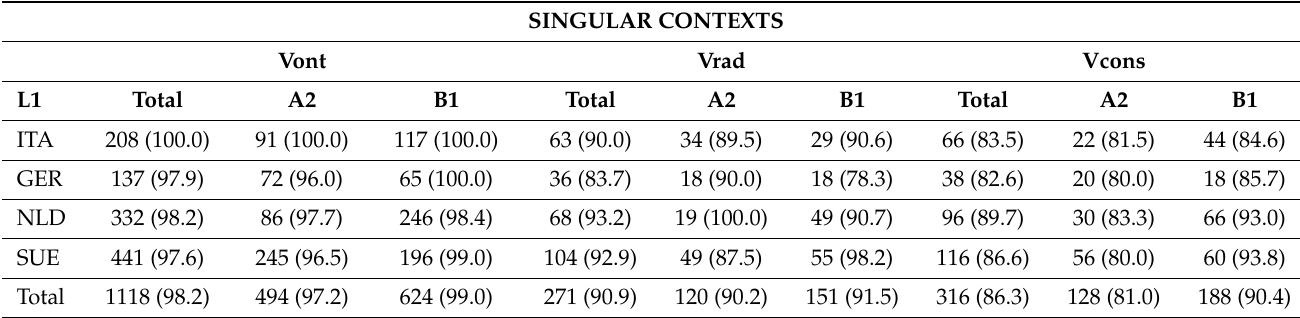
Table 6. Number of correctly agreeing verb forms in singular contexts in the three different agreement patterns Vont, Vrad and Vcons (proportions within brackets).